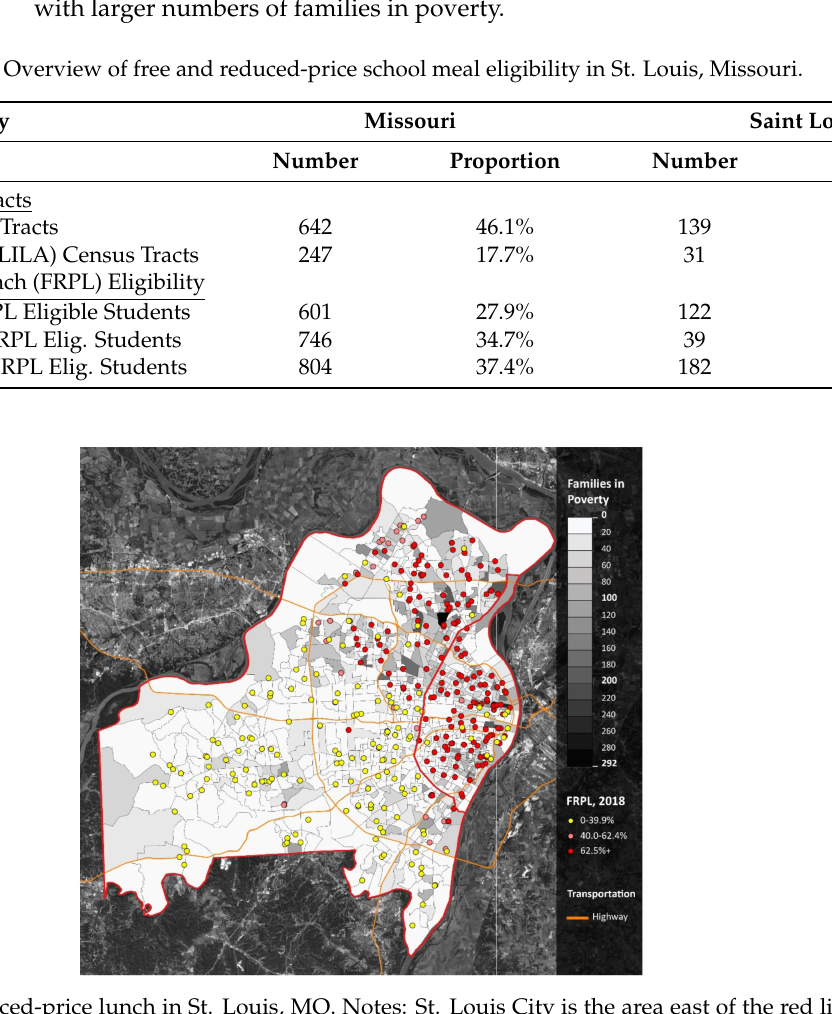
Figure 2. Free and reduced-price lunch in St. Louis, MO. Notes: St. Louis City is the area east of the red line. St. Louis County is the area west of the red line. Dots represent free or reduced- price Lunch categories from the 2018–2019 school year. Orange lines represent major highways. Darker shades of gray represent larger numbers of families in